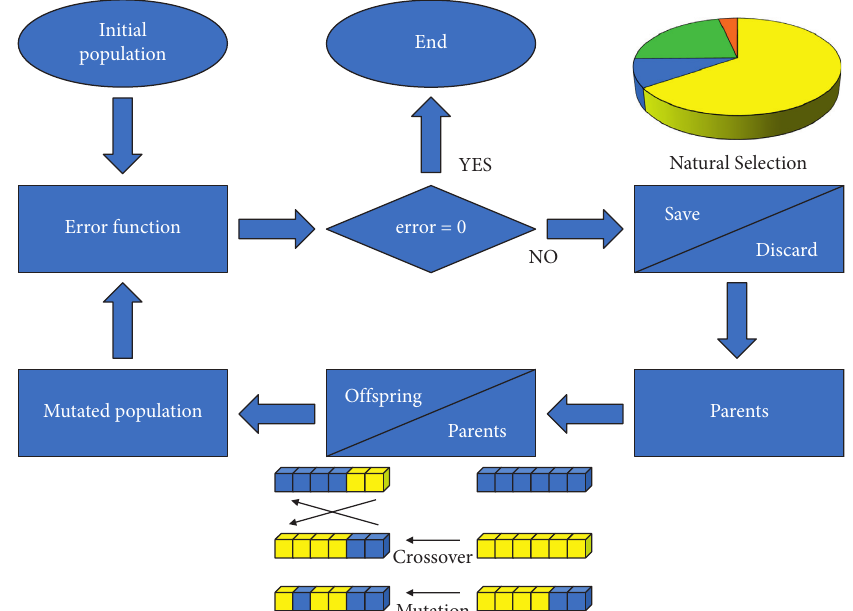
Figure 1: Flowchart of a simple genetic algorithm.